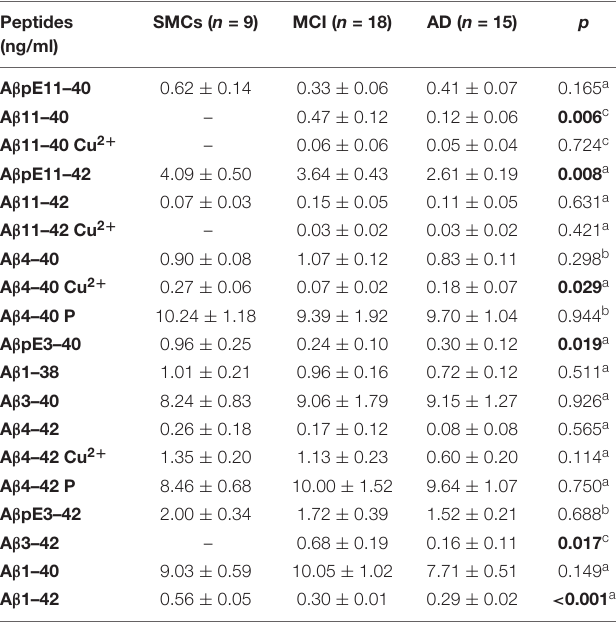
TABLE 2 | A β peptide concentrations in the three study